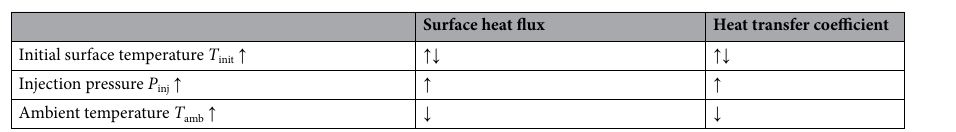
Table 3. Effects of the different experimental factors on the heat transfer characteristics of spray-wall impingement. ↑ : increase; ↓ : decrease; ↑↓ : first increase and then